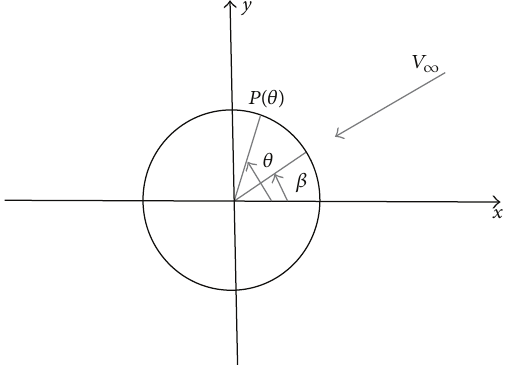
Figure 3: Two-dimensional flow about a right circular cylinder.